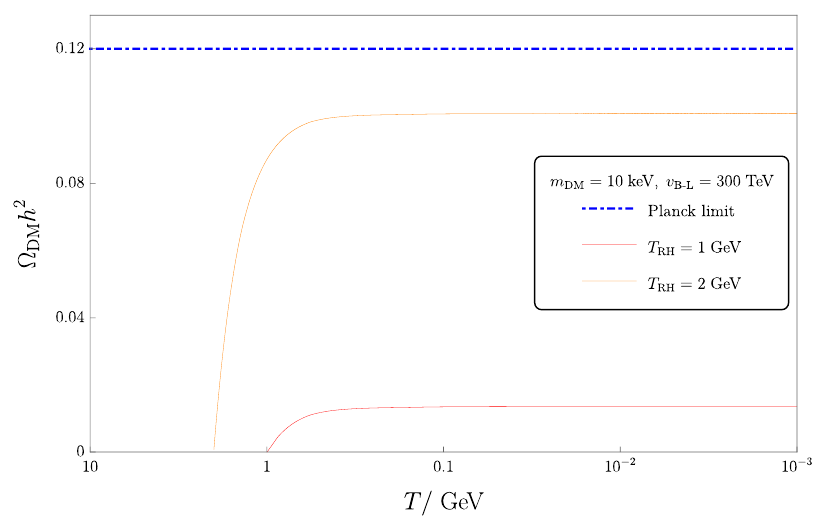
Figure 3 . DM abundance as a function of temperature for fixed m DM , v B-L and two different T RH .